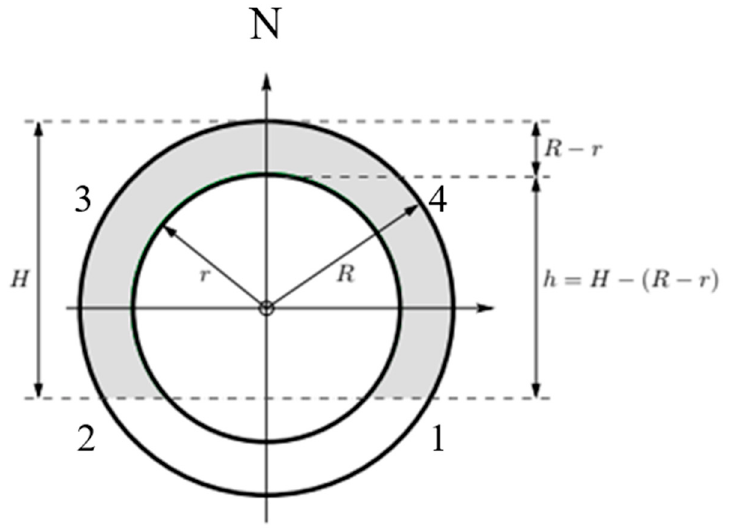
Figure 4. Shrub’s cross-sectional view assuming an approximate spherical shape of the shrub indi- cating the effective fruiting distance, R − r , (shaded) and fruiting height, h ). The numbers around the shrub indicate the quadrants (numbers 1 to 4), q indicates the direction of sampling around the shrub. H refers to the fruiting height of the